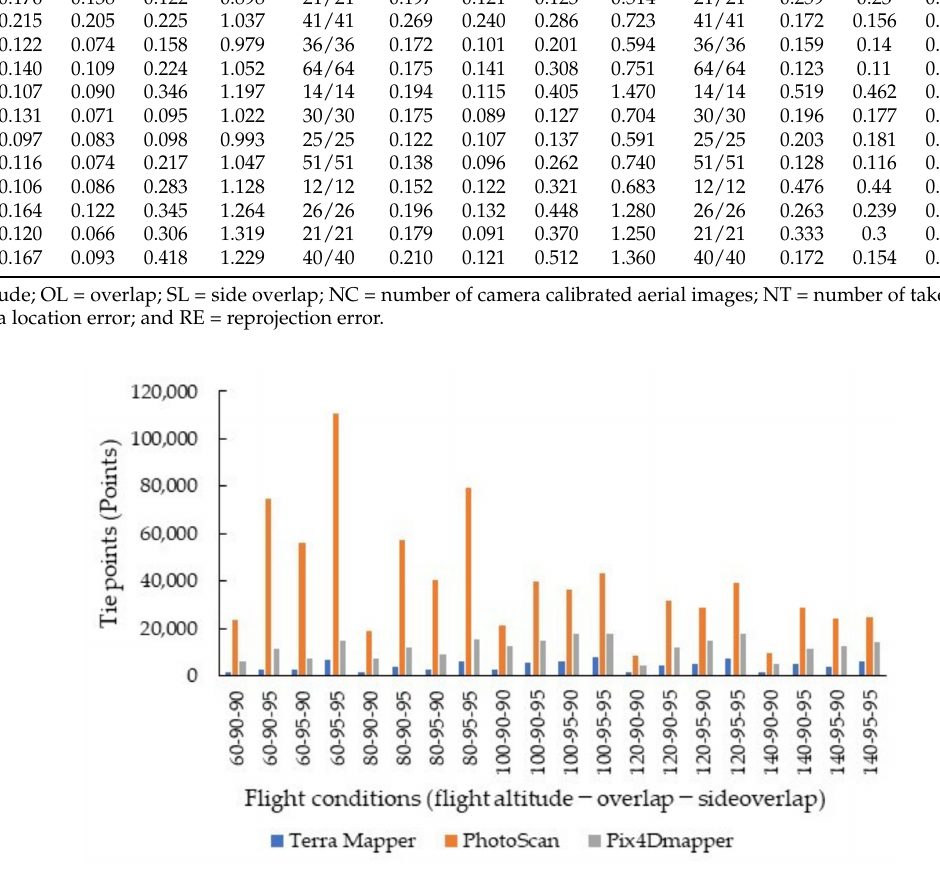
Figure 4. The number of tie points for each SfM